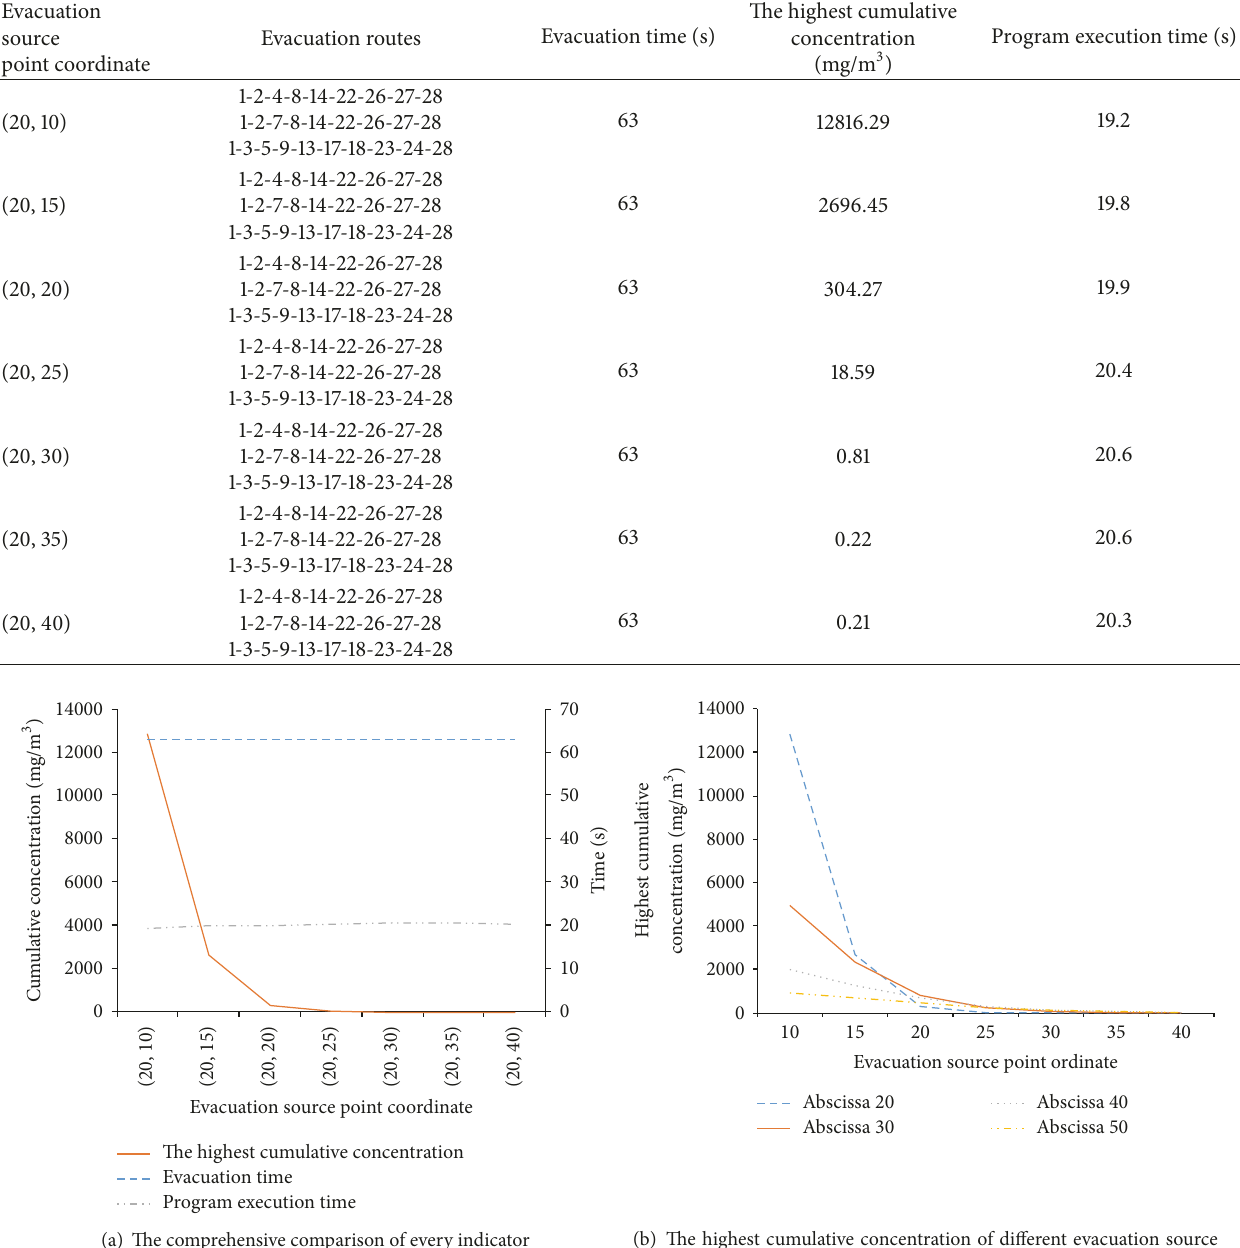
Figure 8: The results of different evacuation source point